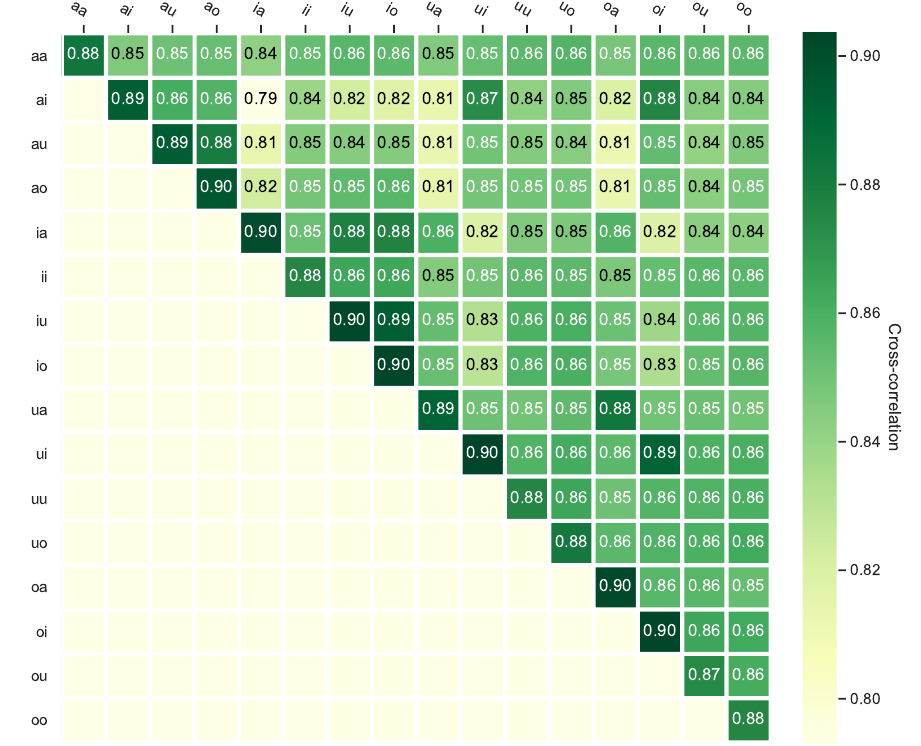
Figure A3. CC mfcc calculated between samples from reference dataset. Higher values correspond to acoustically more similar samples.